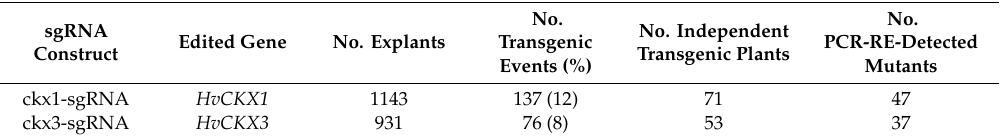
Table 1. Summary of the genetic transformation of barley and the PCR/RE screening of transformants for the presence of induced mutations in the HvCKX1 and HvCKX3 genes.